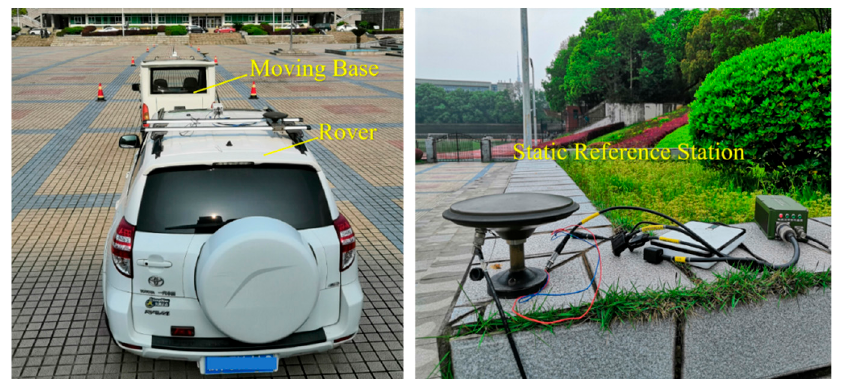
Figure 7. Experimental set up in test 1.